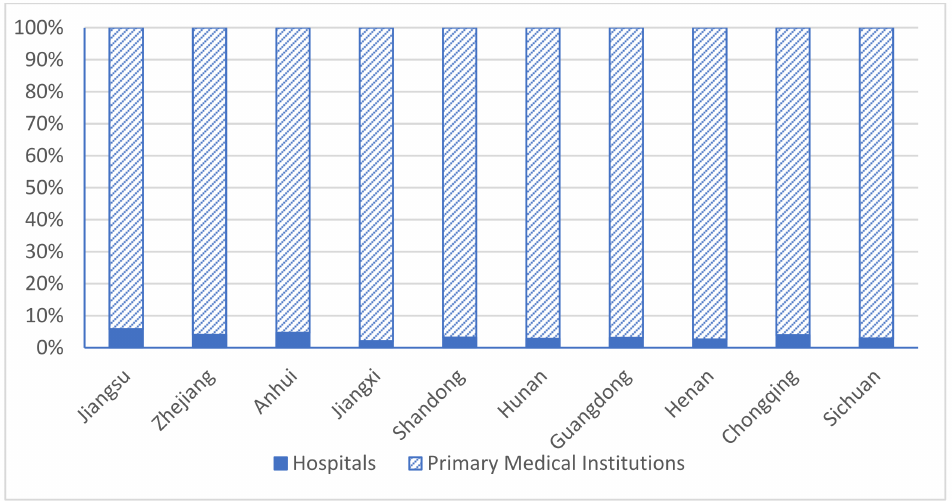
Figure 6. Total number of hospitals and primary medical institutions. Data source: China Health Statistics Yearbook